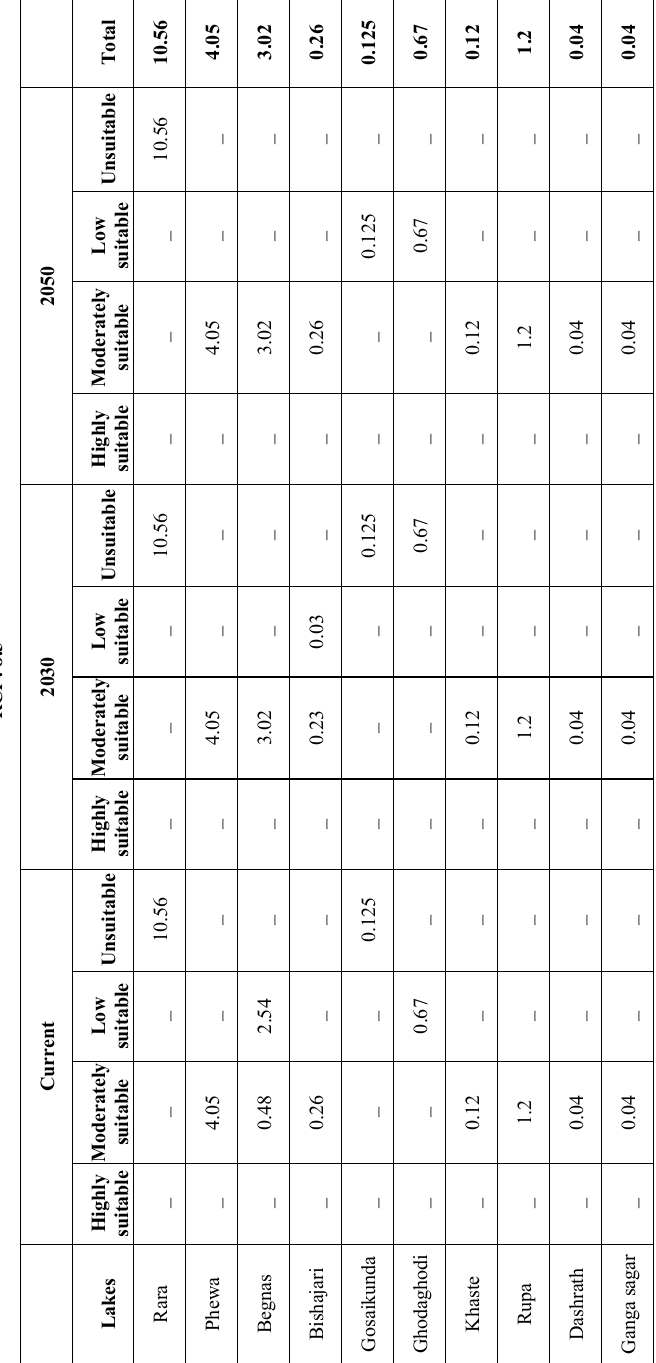
Table 5. Potential Area of water hyacinth in the lakes in current and future scenario under